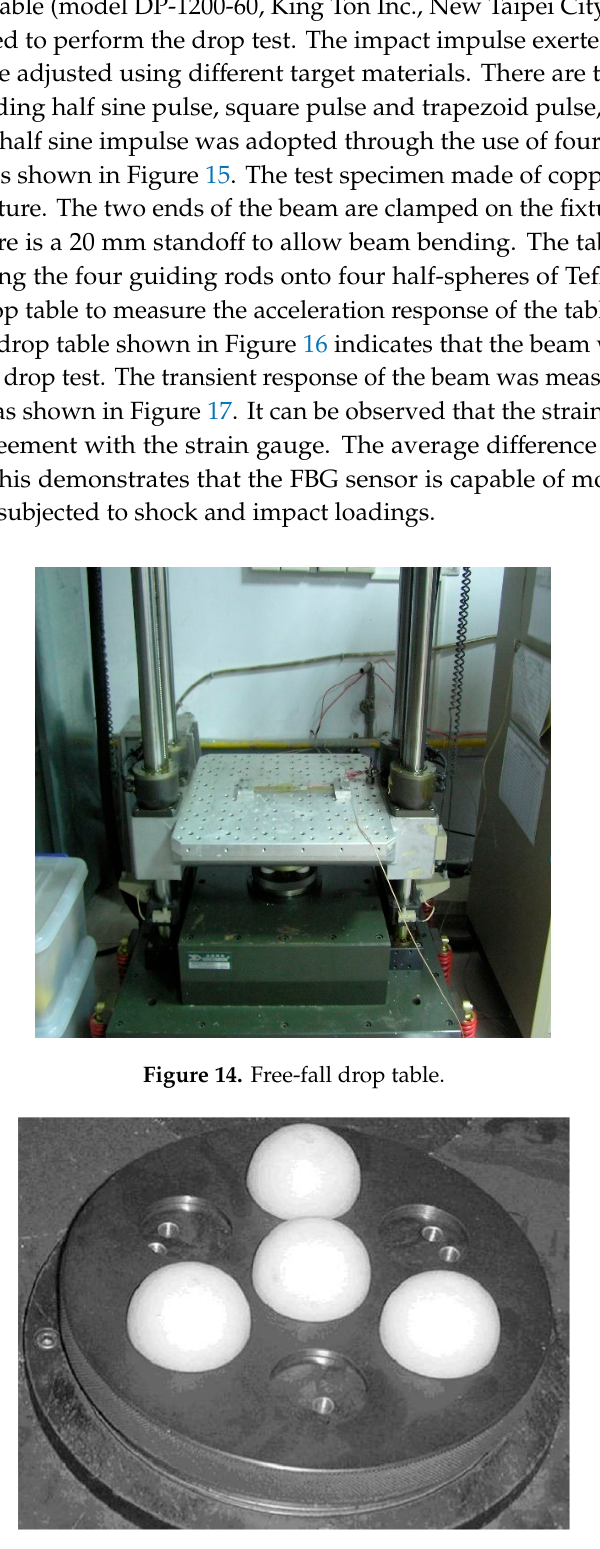
Figure 16. Acceleration of the drop table.